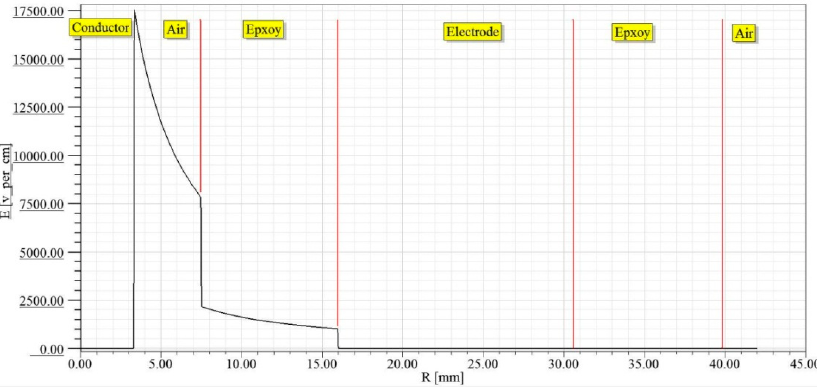
Figure 13. Insulation design simulation result of electrode.